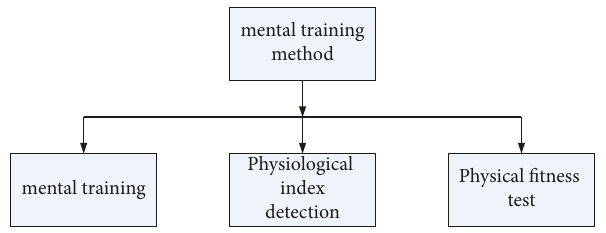
Figure 2: Mental training